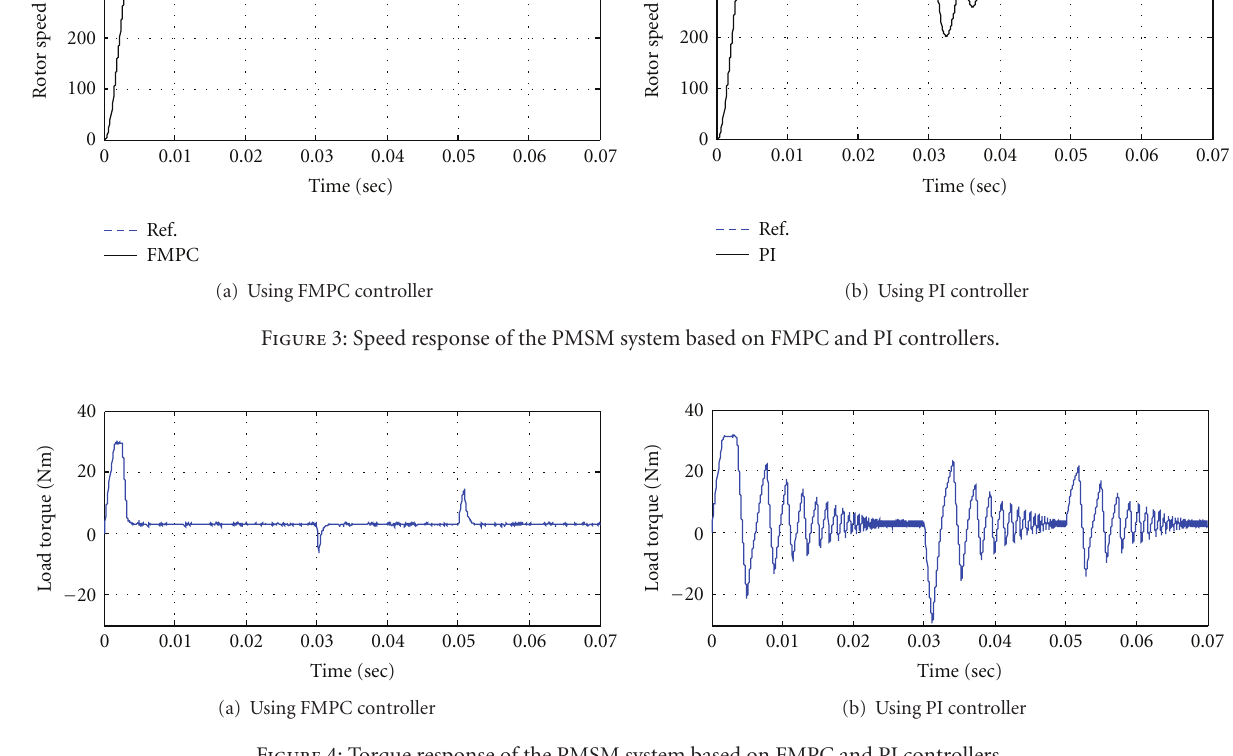
Figure 4: Torque response of the PMSM system based on FMPC and PI controllers.